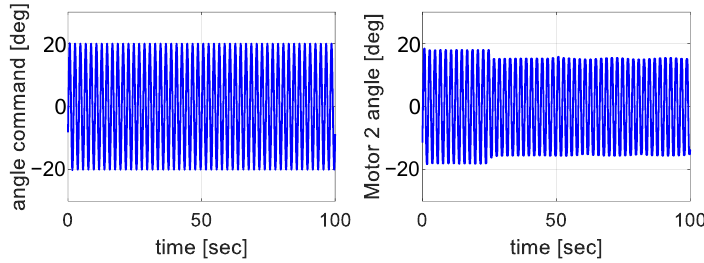
Figure 18. Signals for the fault injection (left) and time-varying weight 𝑤 1 (right).